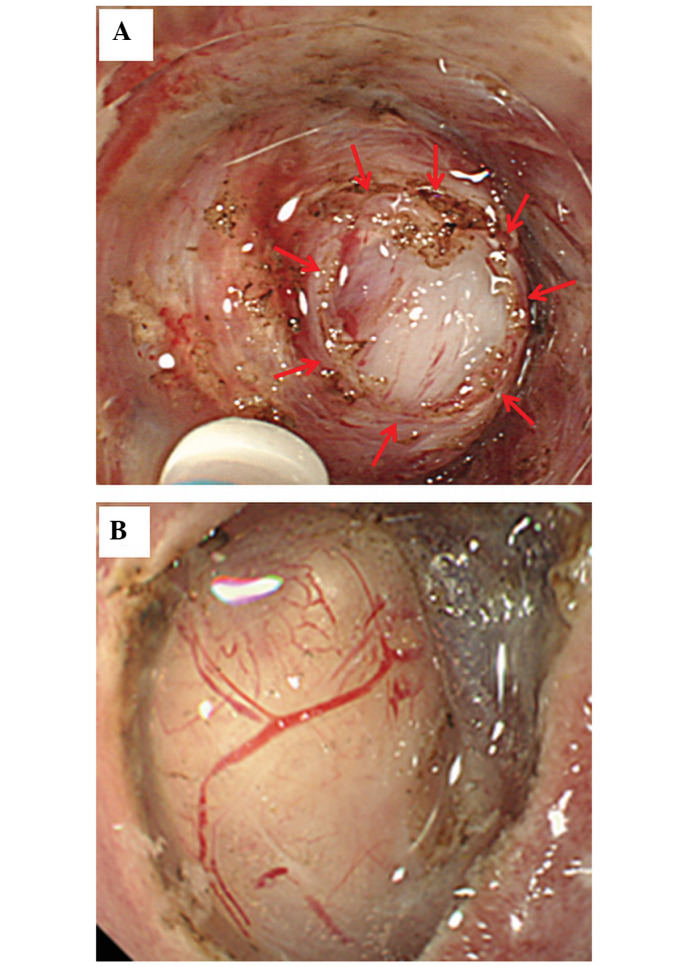
Typical endoscopically visualized feature (EVF) findings of submucosal tumors, with regard to the tumor coating. EVF findings of (A) a gastrointestinal stromal tumor with a visible capsule (red arrows indicate the perimeter of the capsule; case 7) and (B) a granular cell tumor where the capsule is not visible (case 18).